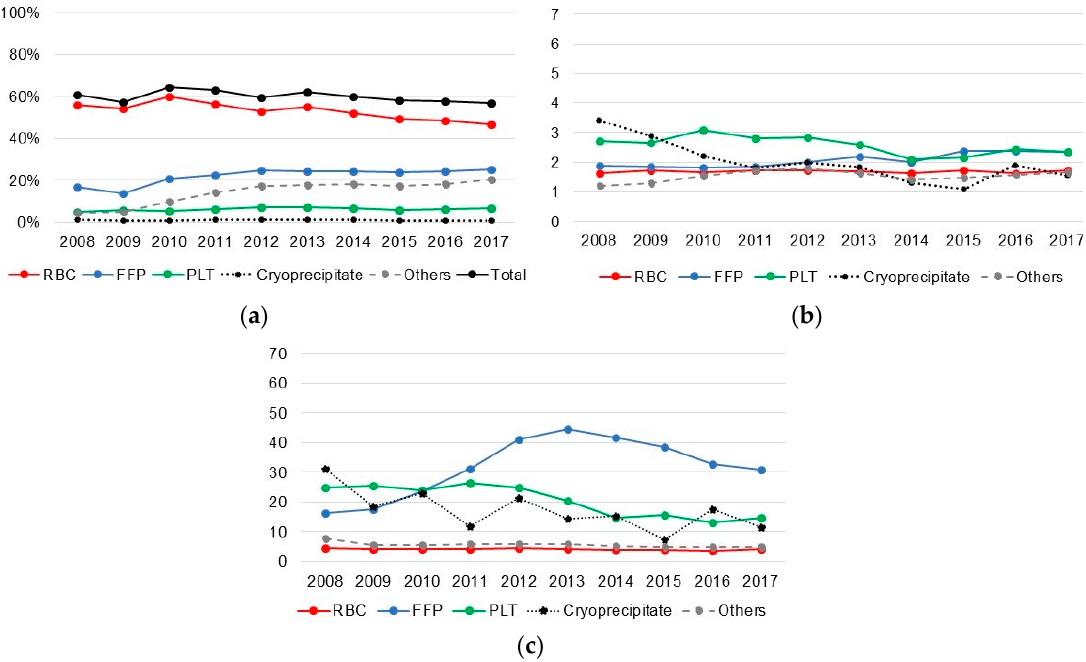
Figure 2. Proportion of transfusion, average count, and amount of transfusion in kidney recipient, 2008–2017. ( a ) Proportion transfusion among kidney recipients; ( b ) Average count of transfusion among kidney recipients; ( c ) Average amount of transfusion among kidney recipients. RBC: red blood cell; FFP: fresh frozen plasma; PLT: platelet.